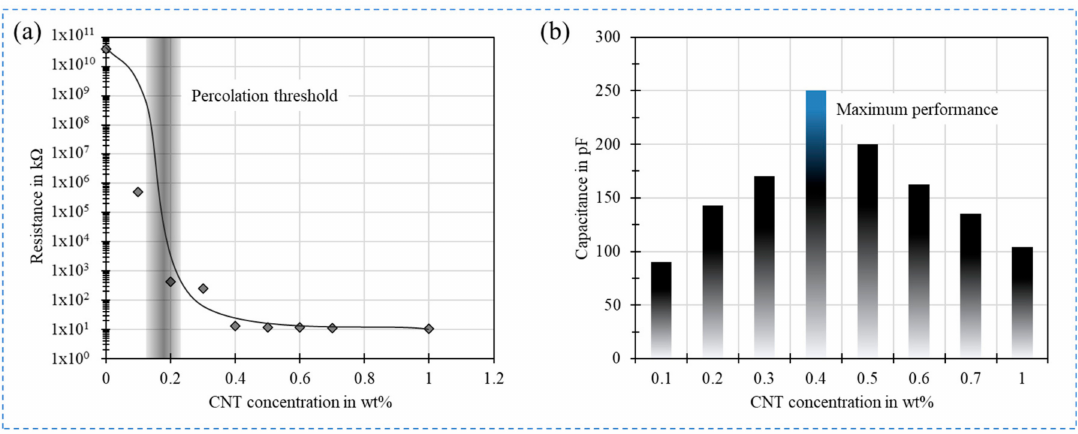
Figure 10. Effect of CNT concentration on the performance of the sensor: ( a ) piezoresistive sensors and ( b ) piezocapaci- tive